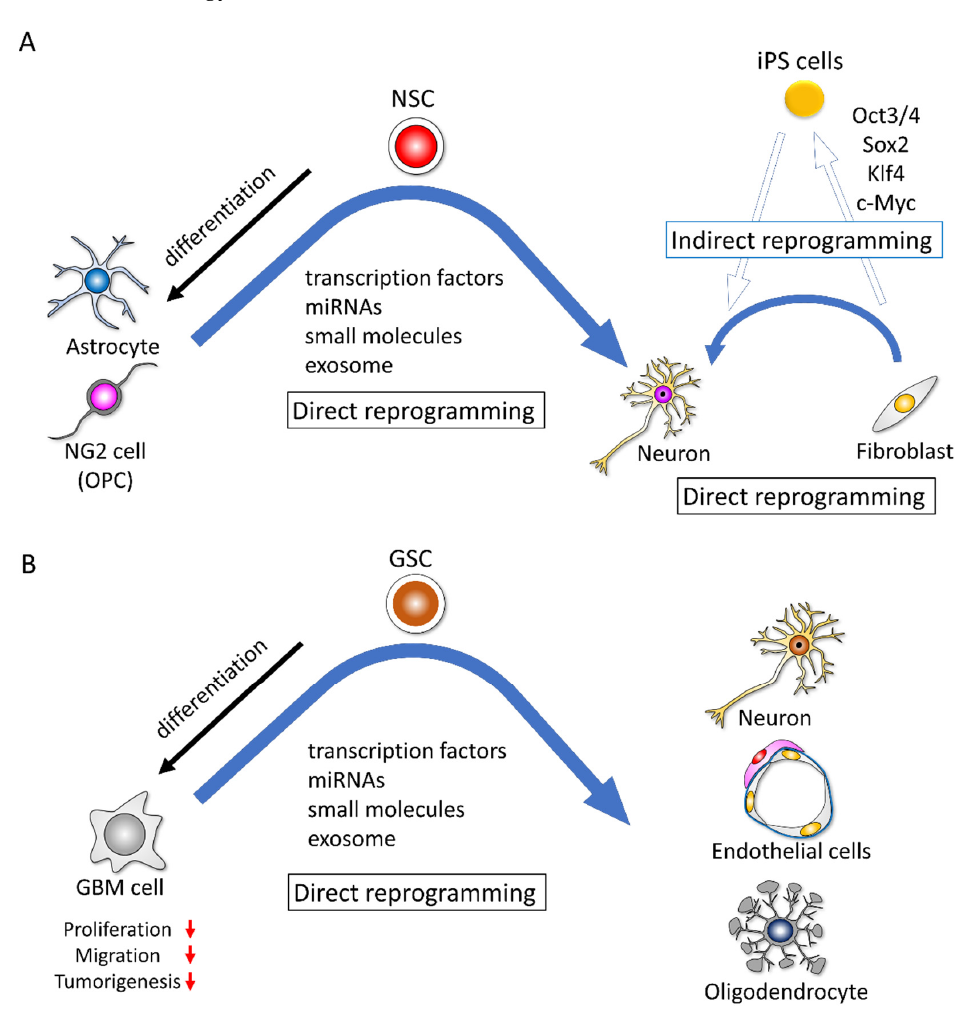
Figure 2. Indirect reprogramming and direct reprogramming in normal cells and GBM cells. ( A ) In indirect reprogramming, pluripotency is induced in fibroblasts by Yamanaka’s factor (Oct3/4, Sox2, Klf4, c-Myc). These iPS cells are then differentiated into three germ layer cells under suitable differentiation culture conditions. In direct reprogramming, fibroblasts, astrocytes, and neuron-glial antigen 2 (NG2) cells (oligodendrocyte progenitor cells (OPCs)) can be directly converted into neurons by transcription factors, microRNAs (miRNAs), small molecules, or exosomes. ( B ) The functions of proliferation, migration, and tumorigenesis are downregulated in the differentiated GBM cells. GBM cells can be directly converted into neurons, oligodendrocytes, and endothelial- like cells. 3.2. Glioma Cells Possess Potential for Reprogramming and Transdifferentiation In immunohistochemical analyses, there are cases in which some GBM cells are stained with the neuronal marker MAP2. GBM contains a small population of GSCs that possess the potential to differentiate and express other neural lineage marker genes [5]. The induction of the terminal differentiation of GSCs into neural lineage cells and other lineage cell types is an interesting challenge and should be a potential therapeutic option [49–51].